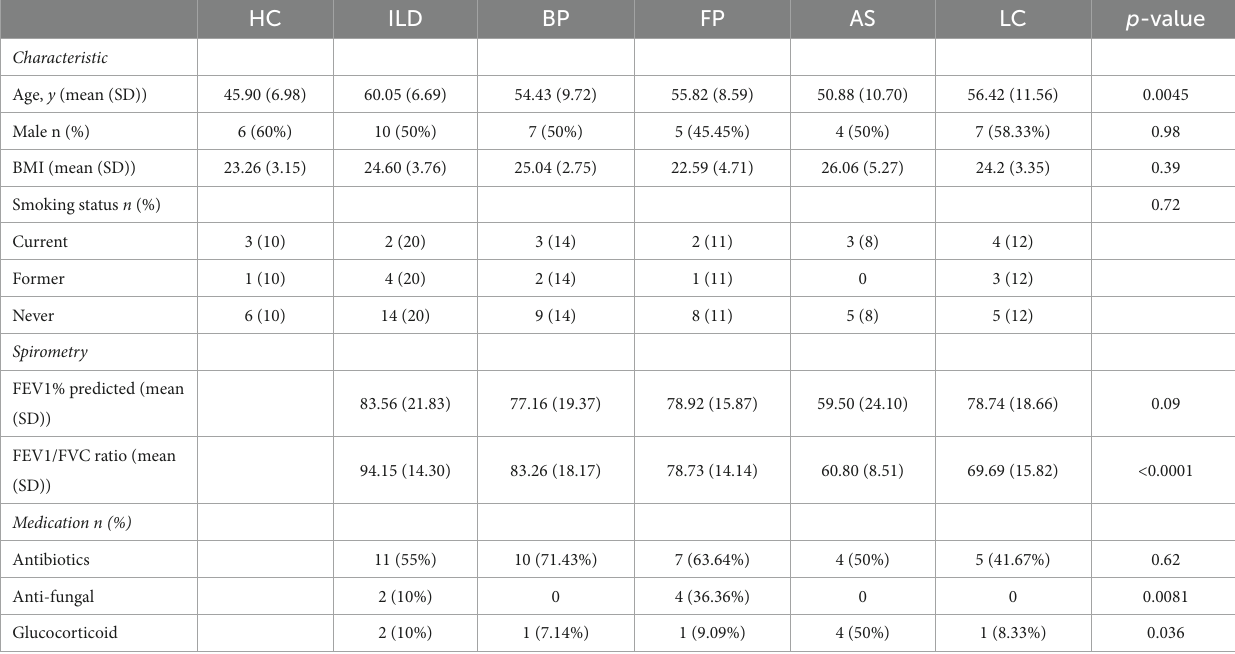
TABLE 1 Demographics and clinical characteristics of the